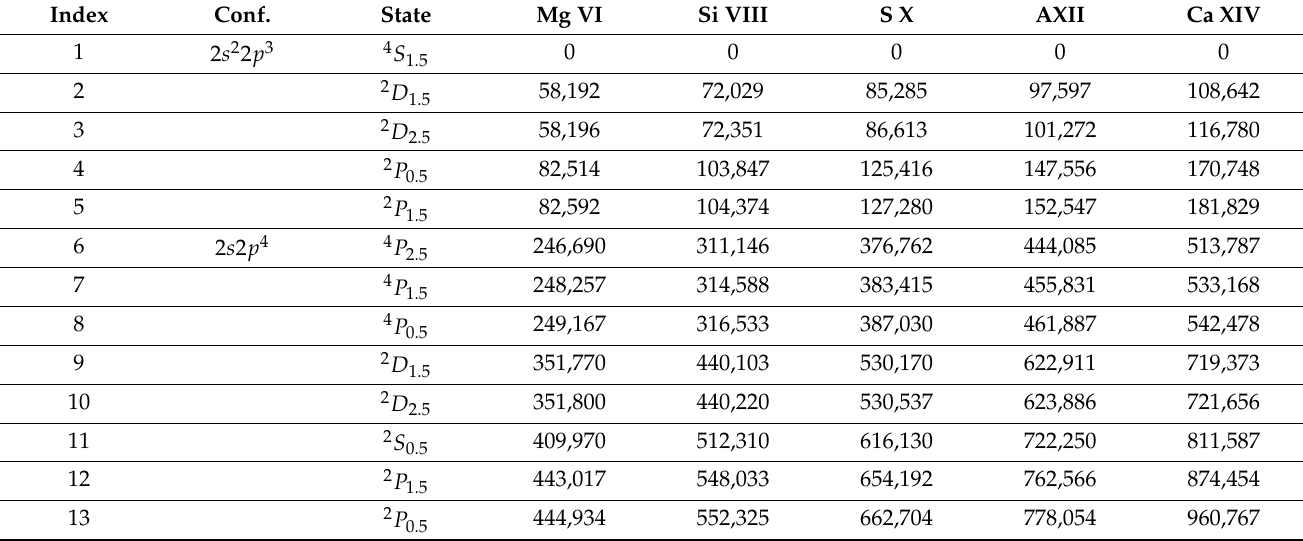
Table 1. Table 1. Energies (cm − 1 ) for various